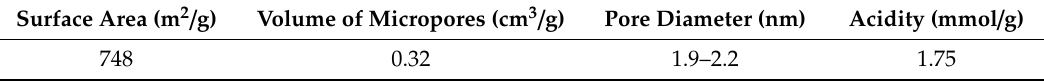
Table 1. Specific parameters of the used zeolite.